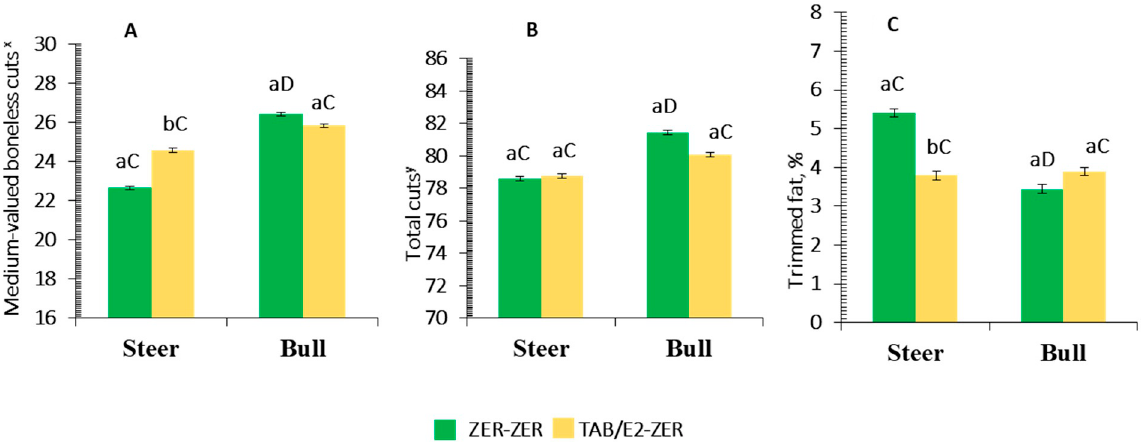
Figure 2. Mean values ± standard error for male class (steer, bull) × implant protocol (IMPL) interaction ( p < 0.05) for percentage yield of cold carcass weight in medium-valued boneless cuts ( x sum of shoulder clod and top blade + chuck tender + chuck roll) ( p = 0.01; A ); total (saleable) cuts ( y sum of the high-, medium-, and low-valued cuts) ( p = 0.05; B ); and trimmed fat ( p < 0.01; C ). IMPL: ZER-ZER: corresponds to a dose (72 mg) of zeranol at d-0 followed by a second identical dose at d-90; TBA/E2-ZER: corresponds to a first dose containing 140 mg trenbolone acetate + 20 mg estradiol benzoate at d-0, followed by a second dose of zeranol (72 mg) at d-90. Bars with a common superscript lowercase letter (a, b) for IMPL treatments within the same male class do not differ ( p > 0.05). Bars with a common superscript uppercase letter (C, D) for male class within the same IMPL, do not differ ( p > 0.05).